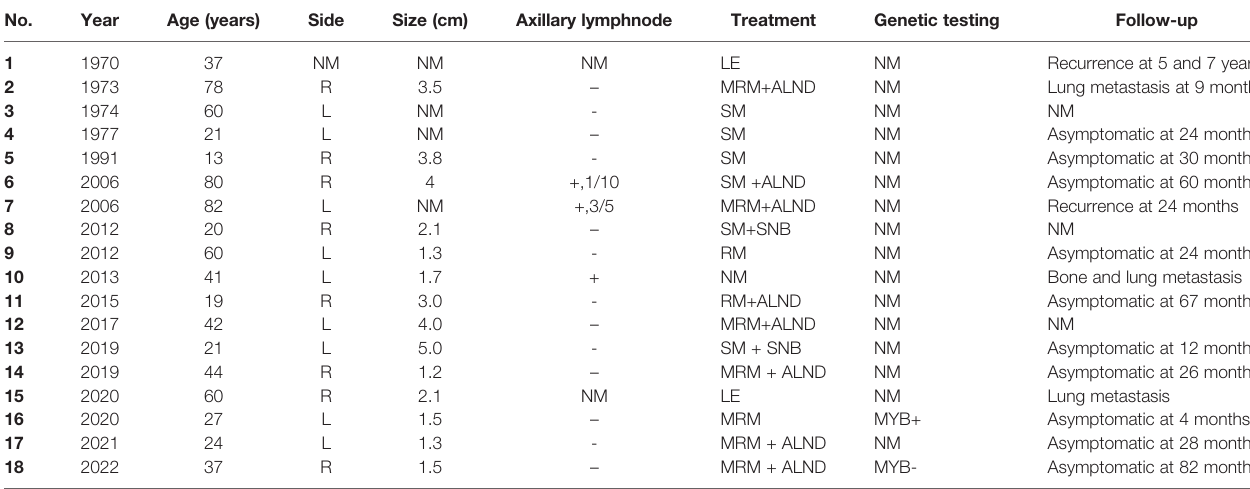
TABLE 1 | Clinical features of reported cases of breast adenoid cystic carcinoma in male patients.